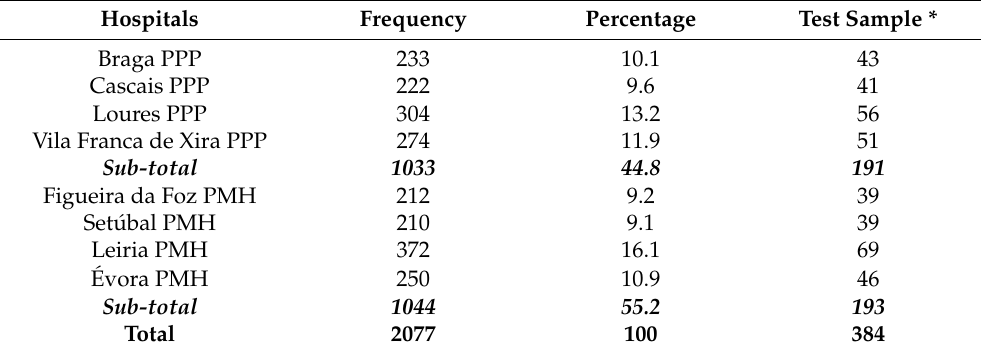
Table 1. Distribution of valid